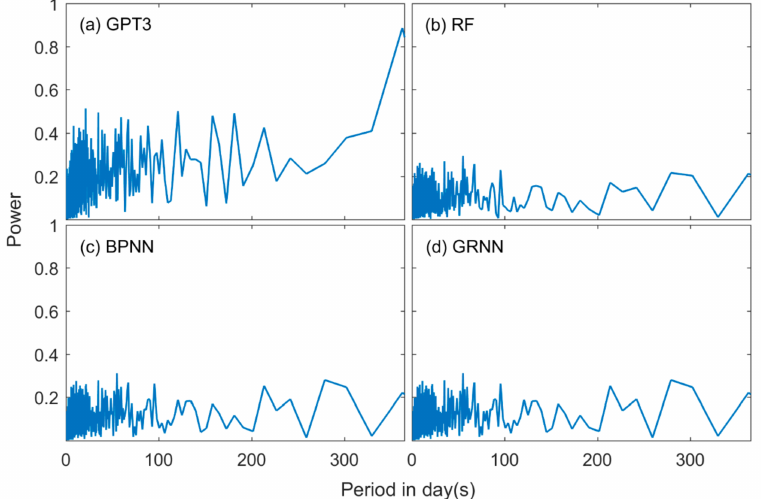
Figure 12. Power spectrums of T m residuals from ( a ) GPT3 (global pressure and temperature model 3), ( b ) RF (random forest), ( c ) BPNN (backpropagation neural network), and ( d ) GRNN (generalized regression neural network) models at the station CHM00057083 (34.71 ◦ N, 113.65 ◦